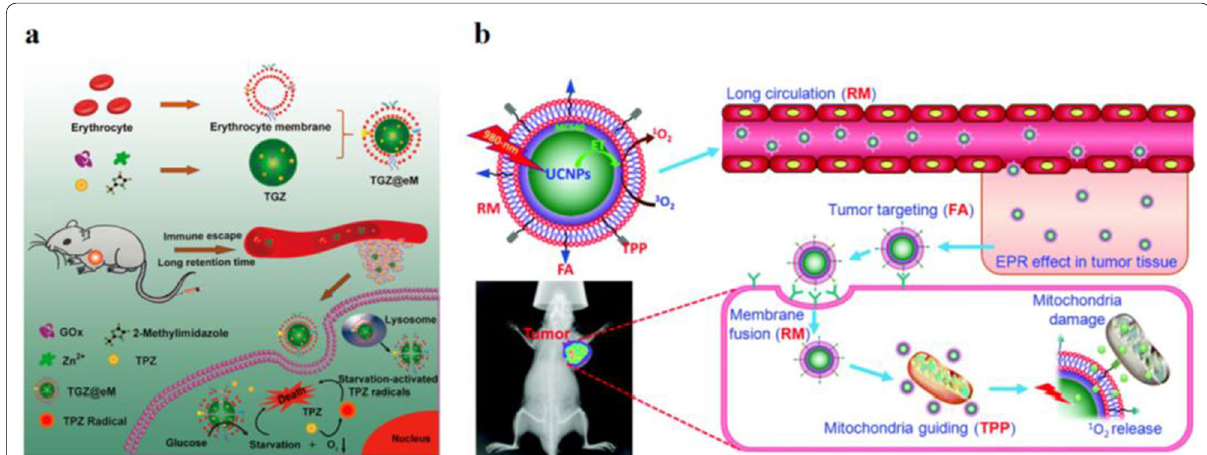
Fig. 1 a Schematic Illustration of the preparation of the TGZ@eM nanoreactor and erythrocyte membrane cloaked MOF biomimetic nanoreactor starvation-activated colon cancer therapy [19]. Copyright 2018 American Chemical Society. b Schematic illustration of UCNP-based EM-coated dual-targeted biomimetic NPs and dual-targeted feature of the agents facilitating the uptake of the target cancer and their efficient location